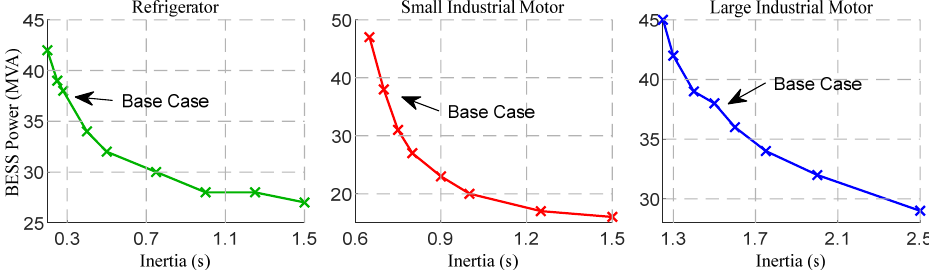
Figure 12. BESS power converter rating vs. induction motor (IM) load inertia sensitivity analysis with respect to different motor load types.